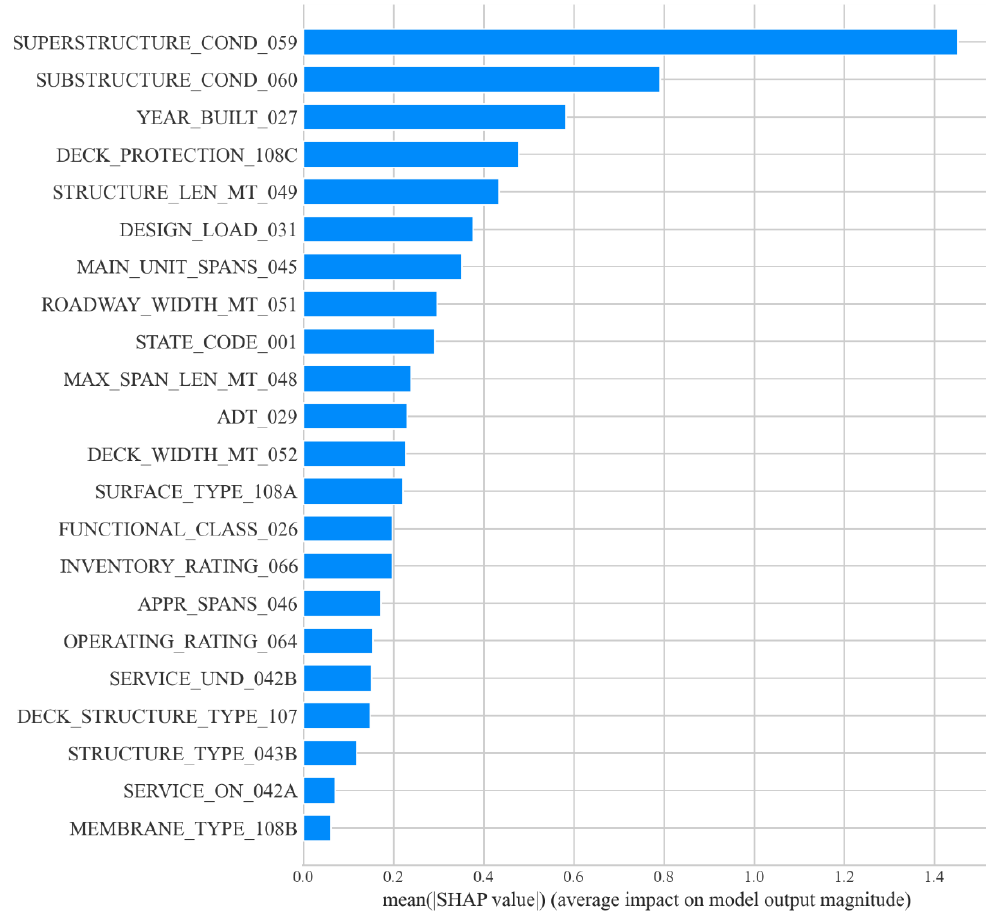
Figure 5. Importance of input feature variables.